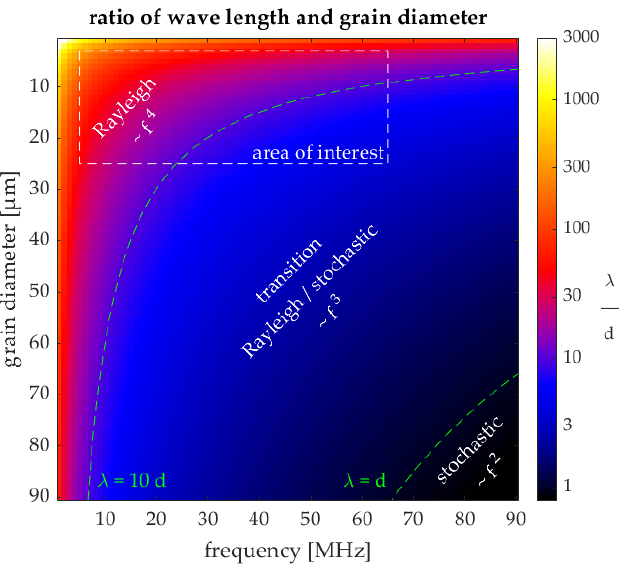
Figure 9. The Rayleigh and stochastic scattering regimes and the transition regime in between. The box on the upper left is the area of interest, bound by the used frequencies and the modelled grain sizes.